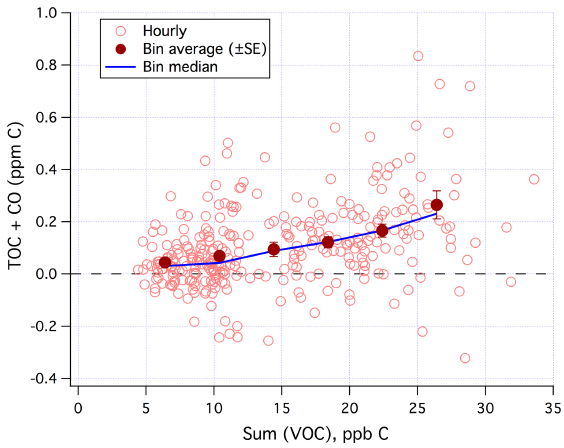
Figure 9. TOC + CO correlated positively with Sum(VOC). Hourly data limited to weekends and weekday nights only.